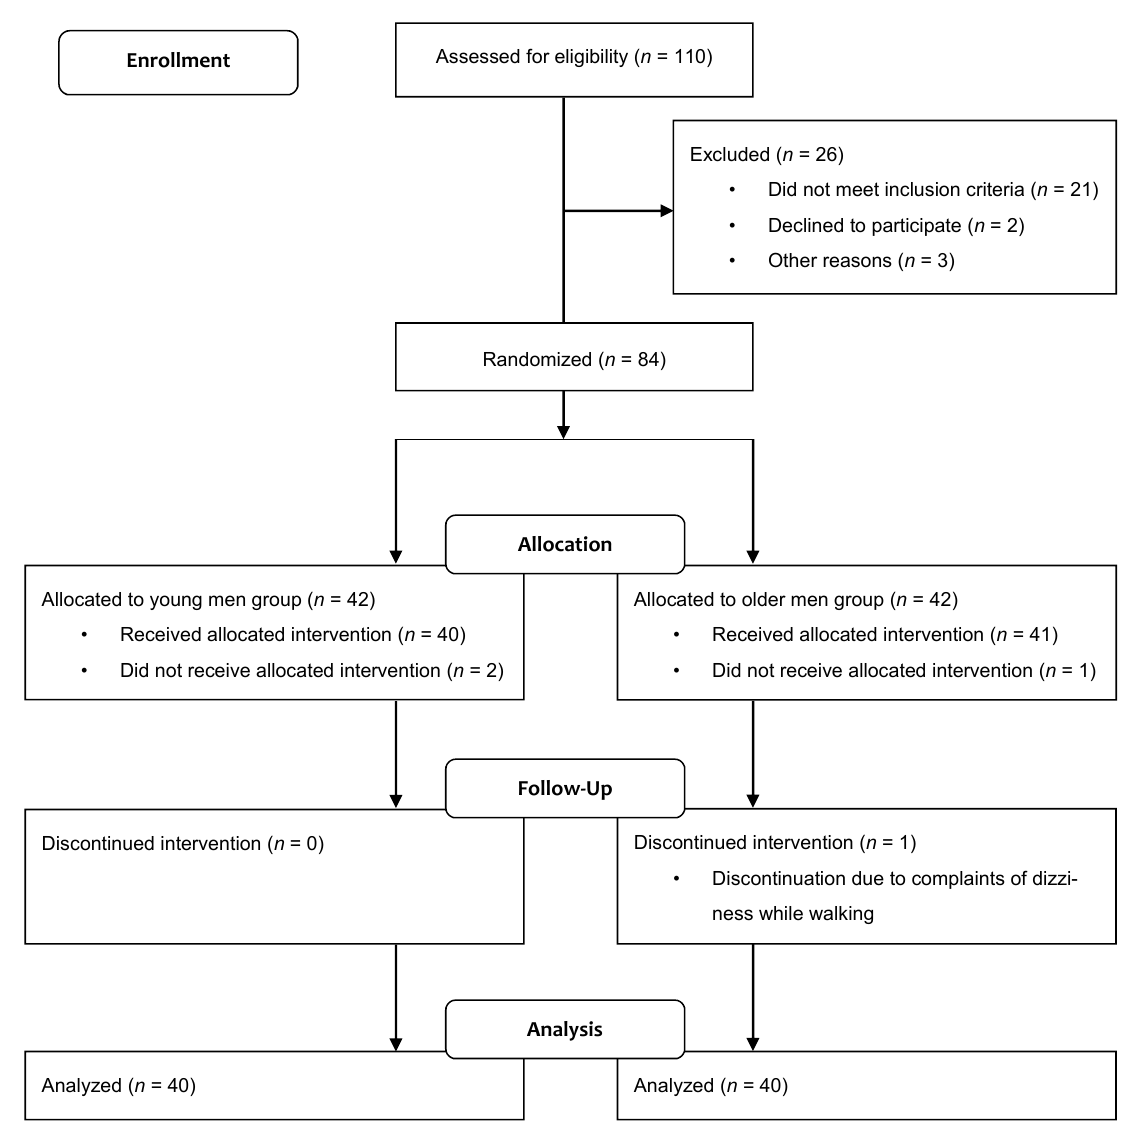
Figure 1. Flowchart showing the experimental design of this study. Table 1. Demographic information of the male